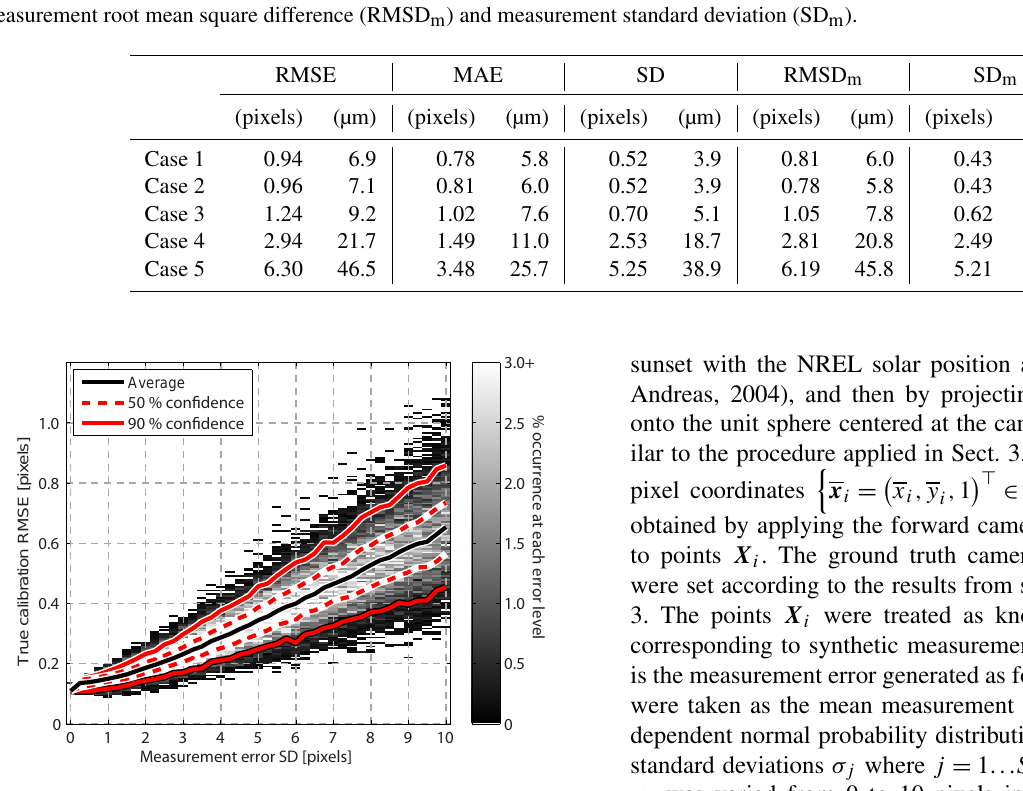
Figure 4. Root mean square calibration error distribution (Eq. 28) as a function of simulated measurement error standard deviation σ j . The mean, 50 and 90% confidence intervals are shown as